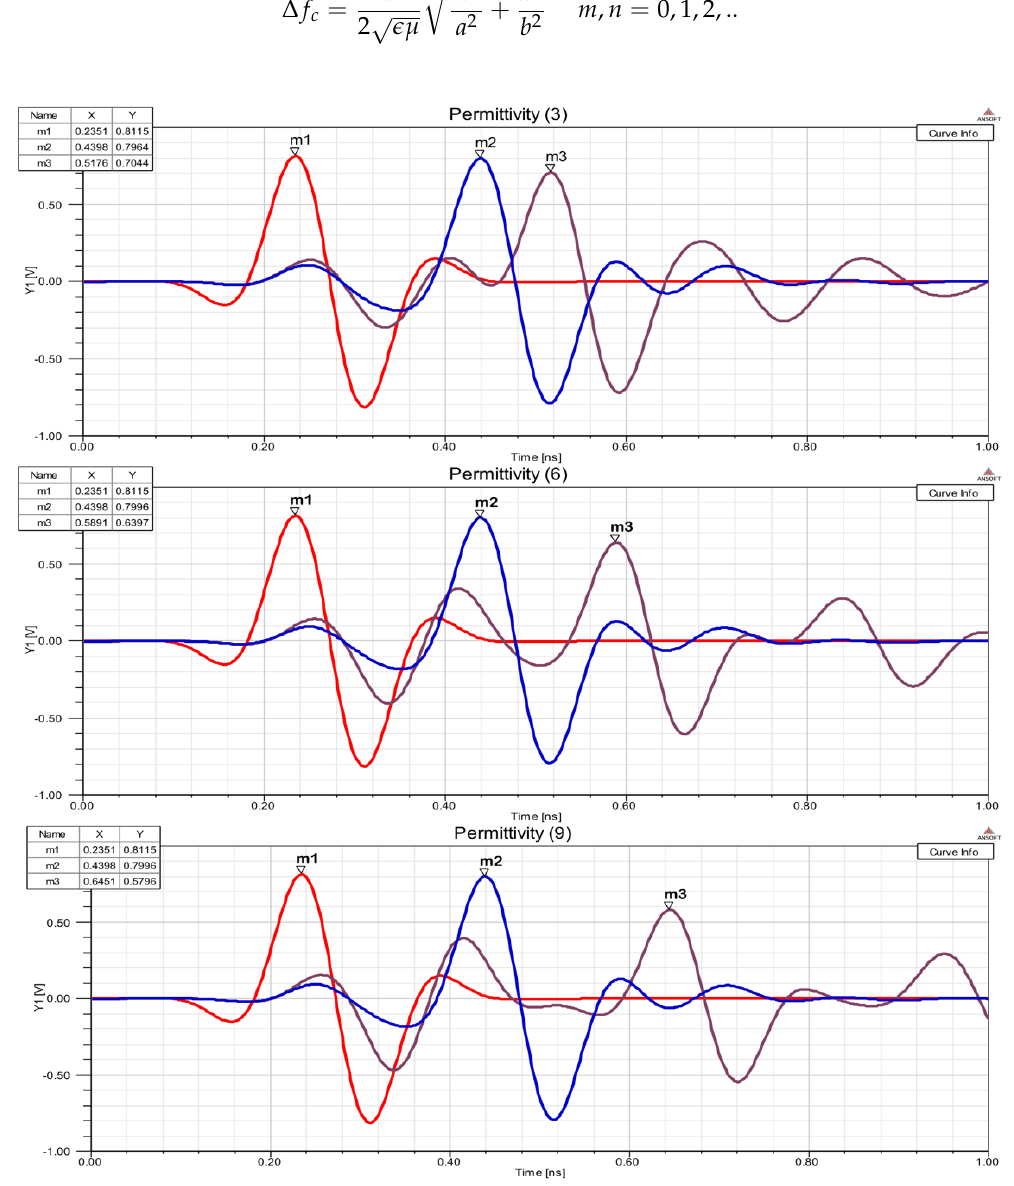
Figure 5. Three pictures with wave propagation simulation (in time domain) using waveguide shown in Figure 4; m 1 is the input pulse, m 2 is output line pulse with (cid:101) = 1, m 3 is output line pulse with unknown (cid:101) r . One input signal is transmitted ( m 1) to the waveguide and derived into the two transmission lines. Two output ports signals are obtained ( m 2 and m 3) and time difference of arrival between two waves are obtained ( ∆ t = m 3 − m 2). The measured difference (4) characterizes (cid:101) m